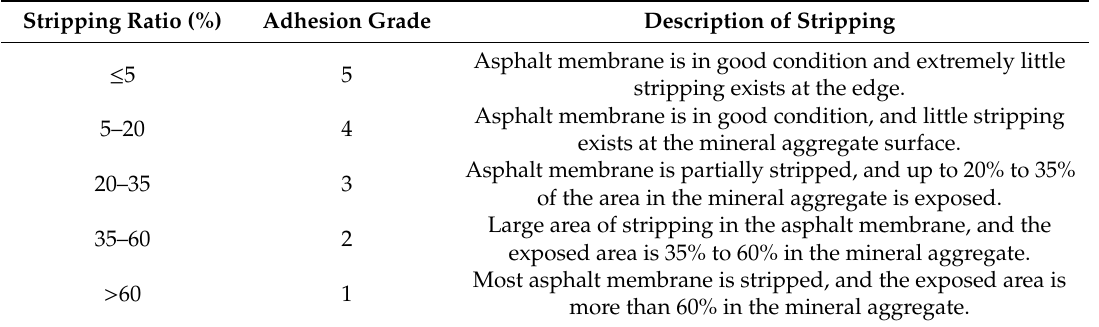
Table 8. Asphalt adhesion grading index.